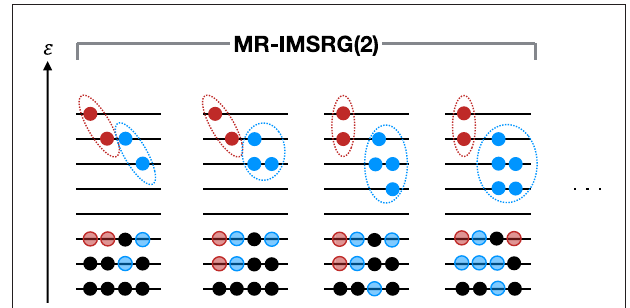
FIGURE 4 | Schematic view of correlations in nuclei. Solid circles indicate nucleons, transparent circles hole states, and dashed ellipses indicate correlations between nucleons. Certain 2p2h, 3p3h and higher correlations (indicated in blue) are built into a correlated wave function that then serves as the reference state for an MR-IMSRG(2) calculation (capturing correlations indicated in red), while up to an IMSRG(A) calculation would be needed for an equivalent description in the conventional